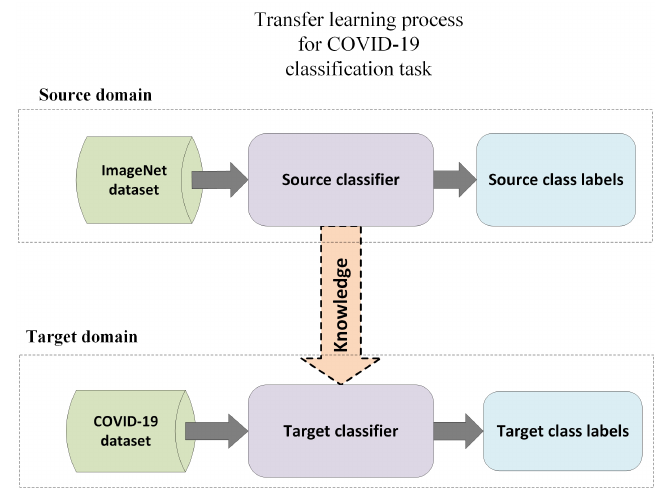
Figure 2. Transfer Learning process.